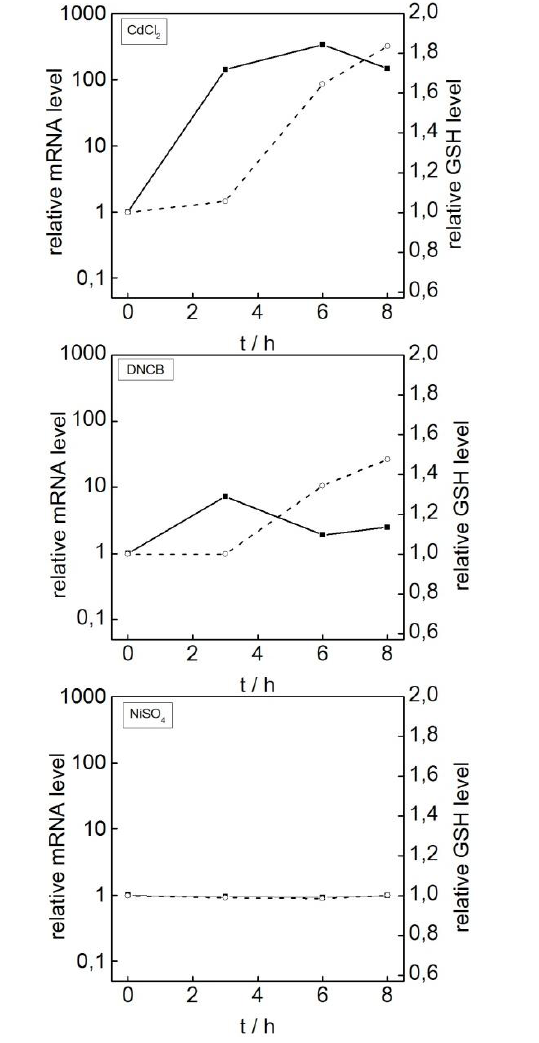
Figure 2. Responses of HaCaT cells to treatments with DNCB and NiSO expression (detected by qRT-PCR) and changes in tGSH levels were measured following the incubation of HaCaT cells with 25 µM CdCl lines represent the detection of the relative mRNA levels of HSP70B’ compared with untreated cells. Dashed lines represent the relative tGSH levels. For each panel, average values from 3–6 independent experiments are